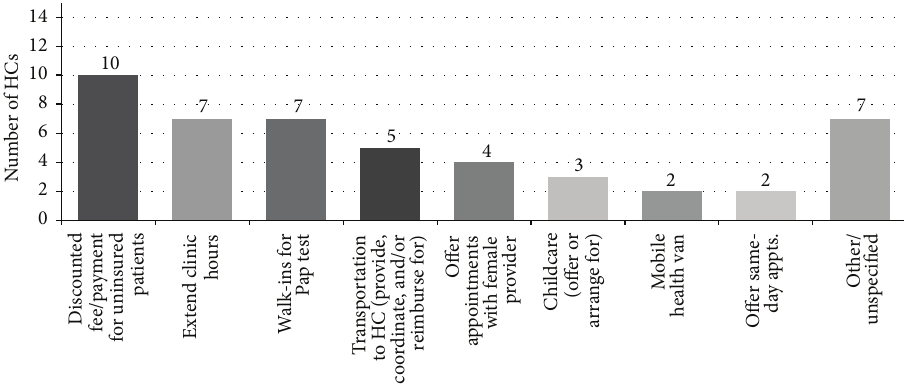
Figure 1: Strategies to facilitate patient access to care.